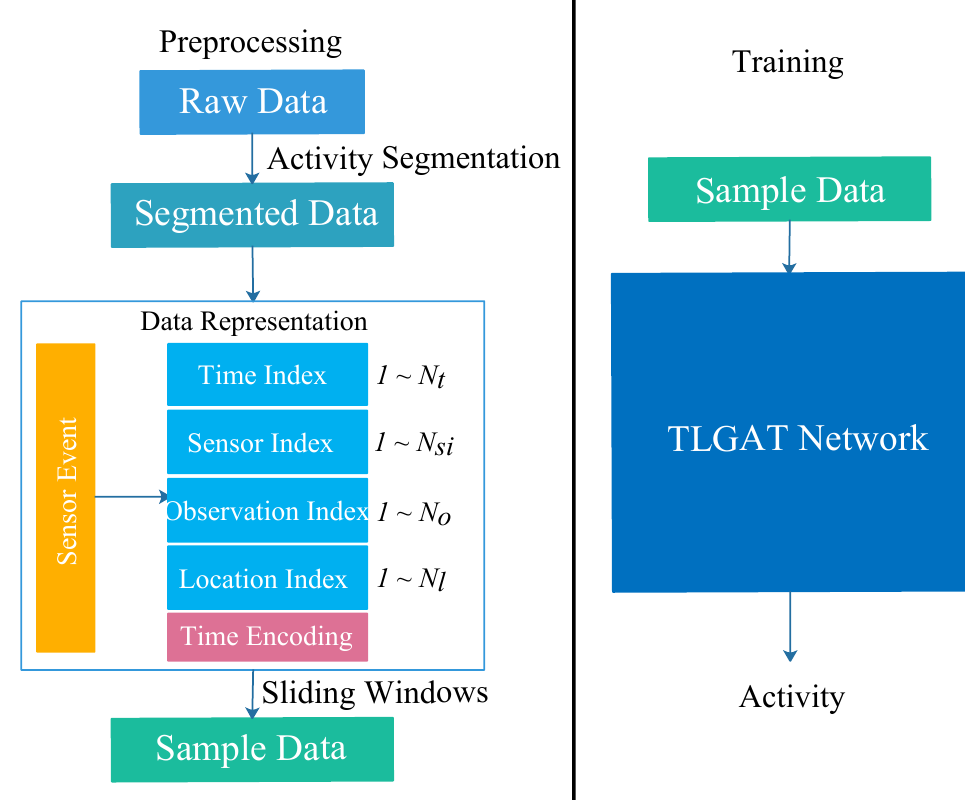
Figure 1. Flowchart of the proposed